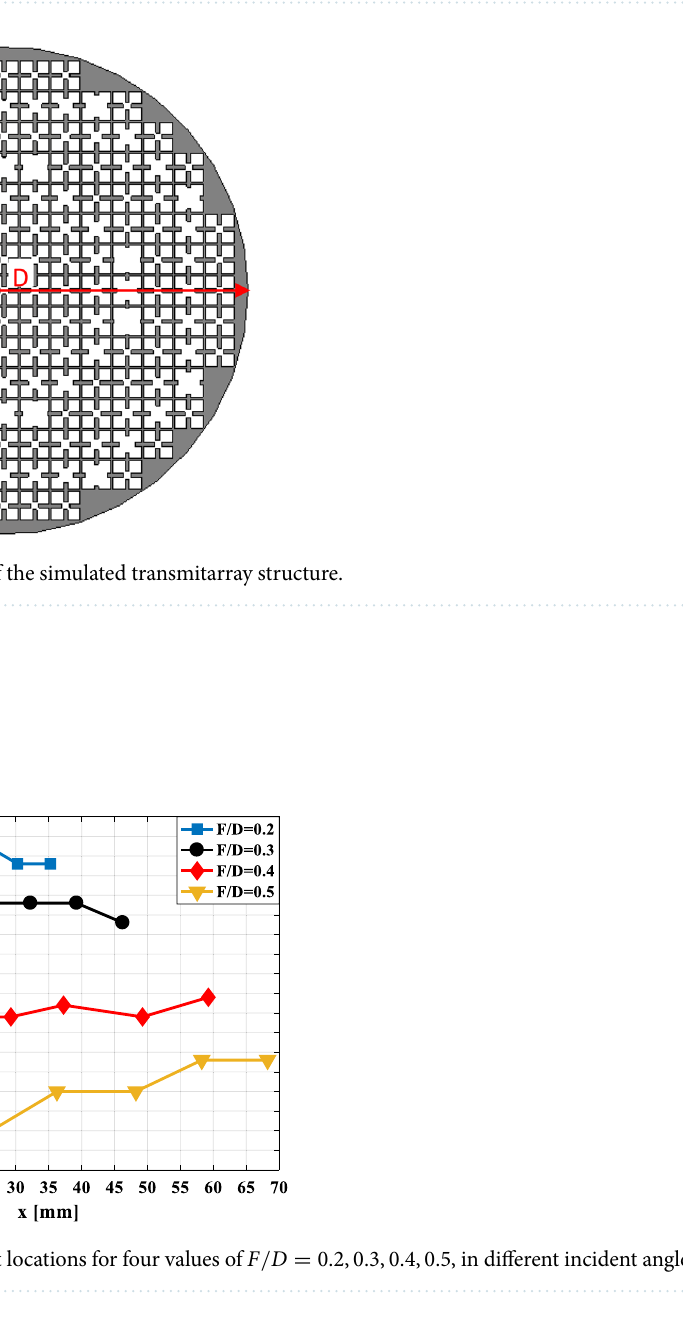
Figure 6. The feed placement locations to achieve retroreflectivity in all azimuth directions.